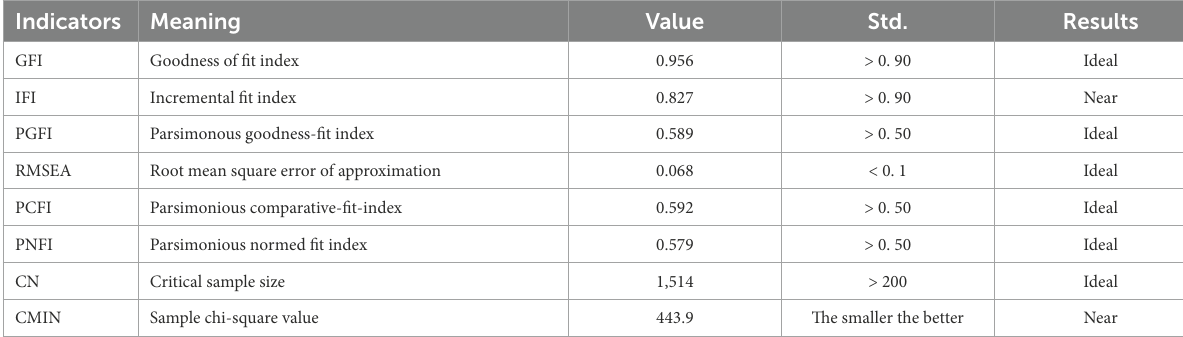
TABLE 3 Model fit report table.